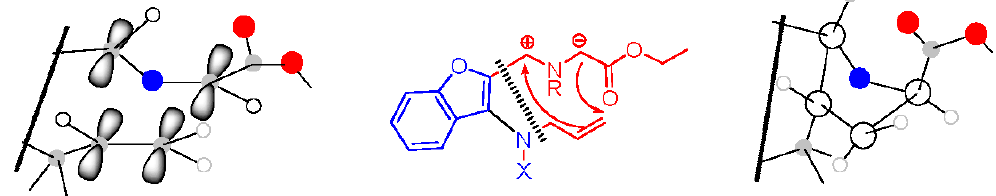
Figure 2. Perspective view of the ylide fragment conformation affording diastereomer 9 with the configuration (2 R *, 3a R *, 10b*) and a schematic view of the product. In the scheme we neglect the plus/minus sign of the wave function; the interactions have a stabilizing effect.